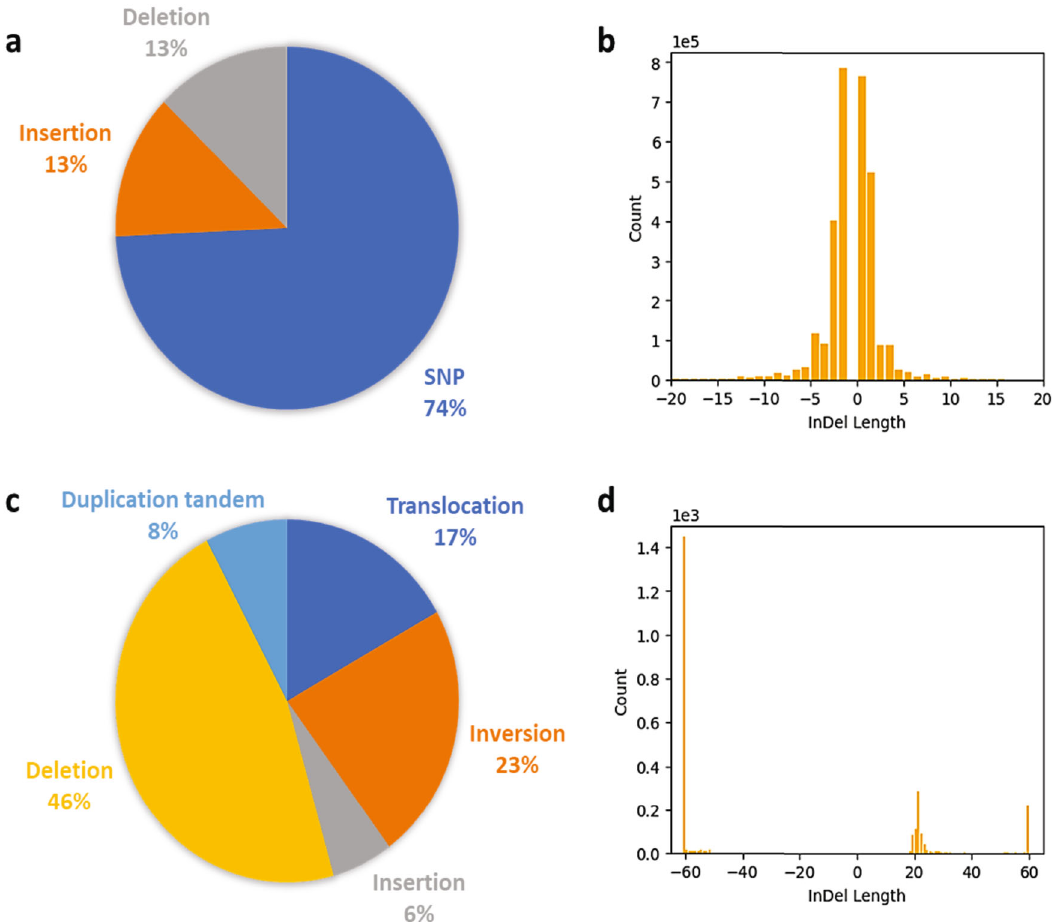
Fig. 3 Characterization of called structural variants. a Different SNVSniffer called small-variant types distributions b SNVSniffer called small- scale indels distribution. c Different Manta called small-variant types distributions. d Manta called large-scale indels distribution.